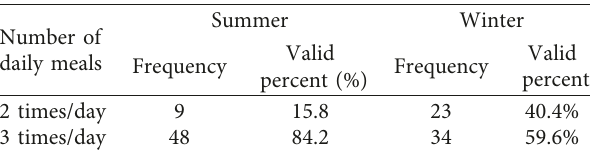
Figure 6: Layout of the test room and testing point arrangement: (a) axonometric view, (b) plan view, and (c, d) heated wall. Table 1: Seasonal variation in the number of daily